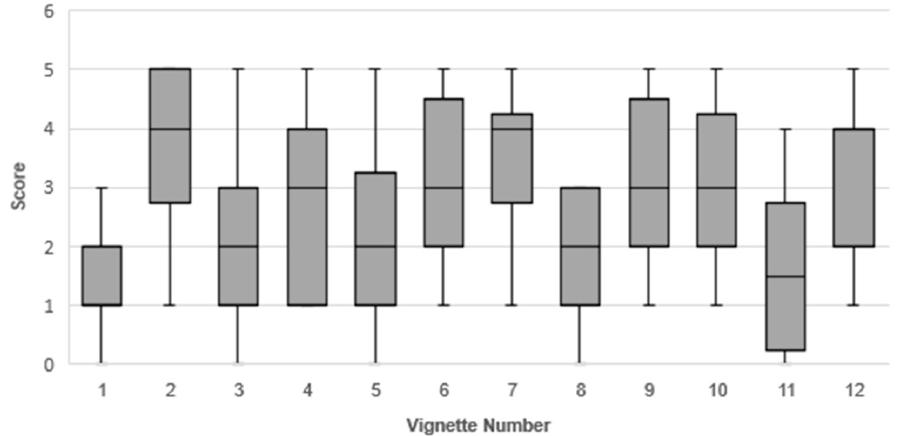
Figure 1. Box and whisker plot of vignette (twelve numbered scenarios) scores as assigned by survey respondents ( n = 14). Vignettes were scored between 0 (welfare is not compromised) and 5 (distress that requires immediate intervention).